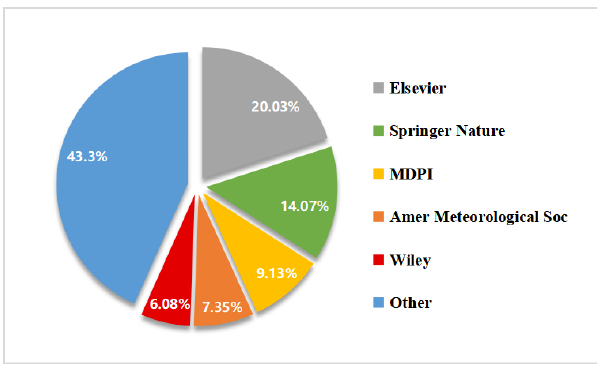
Figure 6. High-yield publisher influence analysis.